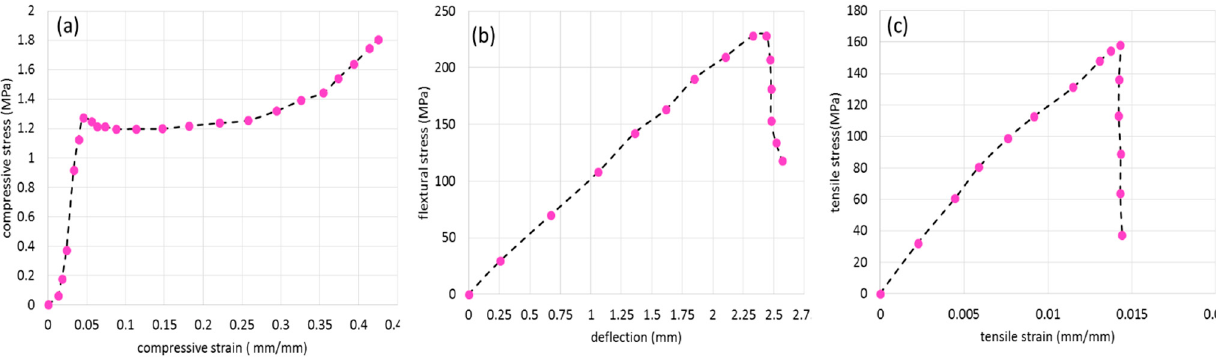
tion curves of glass/polyester laminate, ( c ) The stress-strain curves of glass/polyester laminate [9].